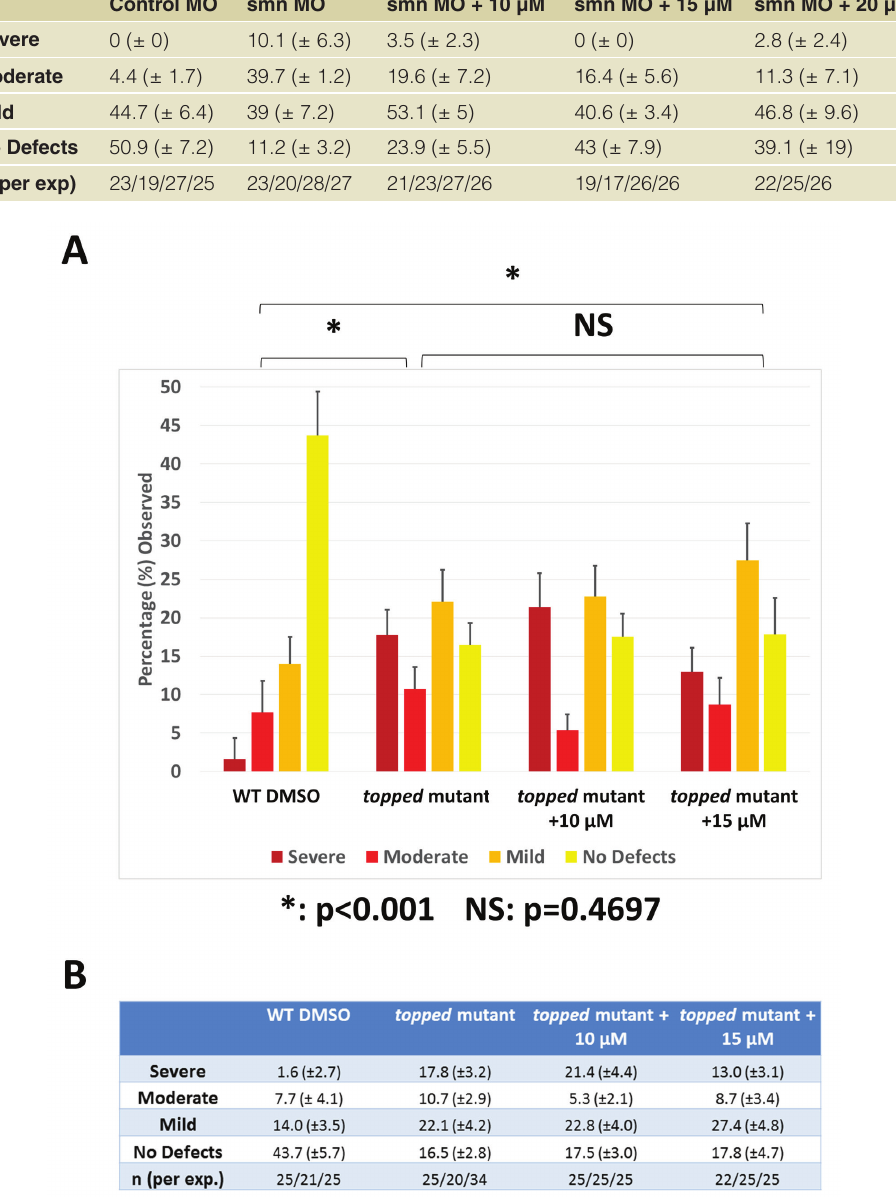
Figure 6. Treatment of zebrafish with MLN4294 fails to rescue defects in ventral motor axon guidance in the topped mutant. ( A ) Quantification of the effects of MLN4294 on motor axon guidance in the zebrafish topped mutant. Motor axons were scored in embryos injected with DMSO, 10 or 15 µM MLN4294. Embryos were classified as severe, moderate, mild, or no defects based on the severity of motor axon defects, and the percentage of each group is shown. Data in all graphs are represented as mean and SEM. ( B ) Experimental